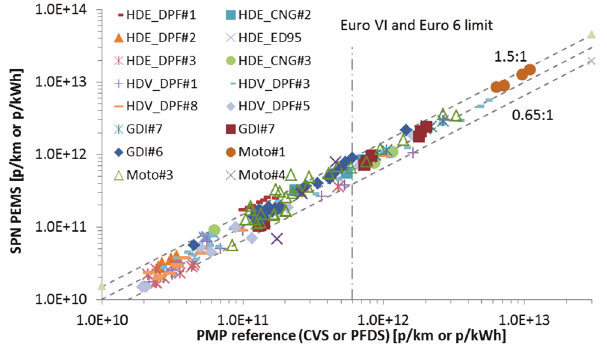
Fig. 8. Summary of L-category, light-duty and heavy-duty results for a CPC-based SPN PEMS compared to reference PMP systems at the full dilution tunnel (CVS) or proportional partial flow dilution systems (PFDS). Each point is a test cycle. Data from [11, 12,